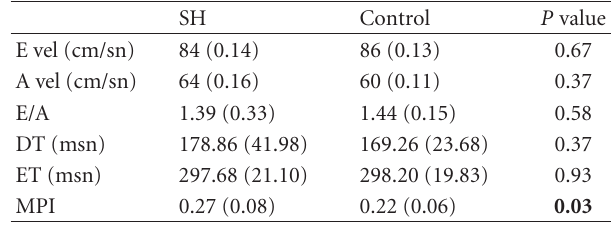
Table 3: Pulsed wave Doppler-derived